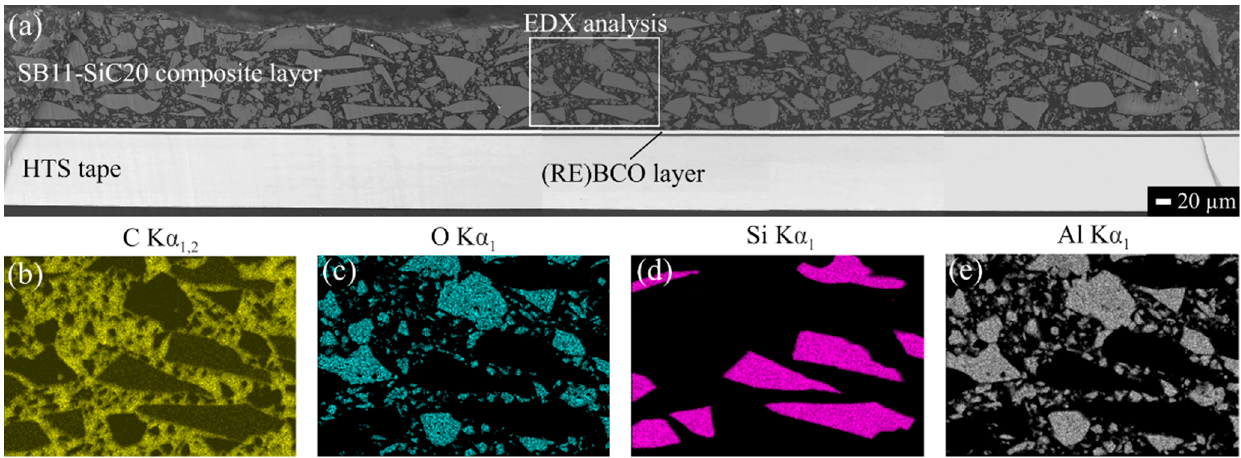
Figure 4. SEM image of the modified HTS tape in cross-section, with homogeneously dispersed filler in matrix of the composite coating ( a ) and its elemental distribution of: ( b ) C; ( c ) O; ( d ) Si and ( e ) Al confirmed by energy-dispersive X-ray (EDX) analysis.